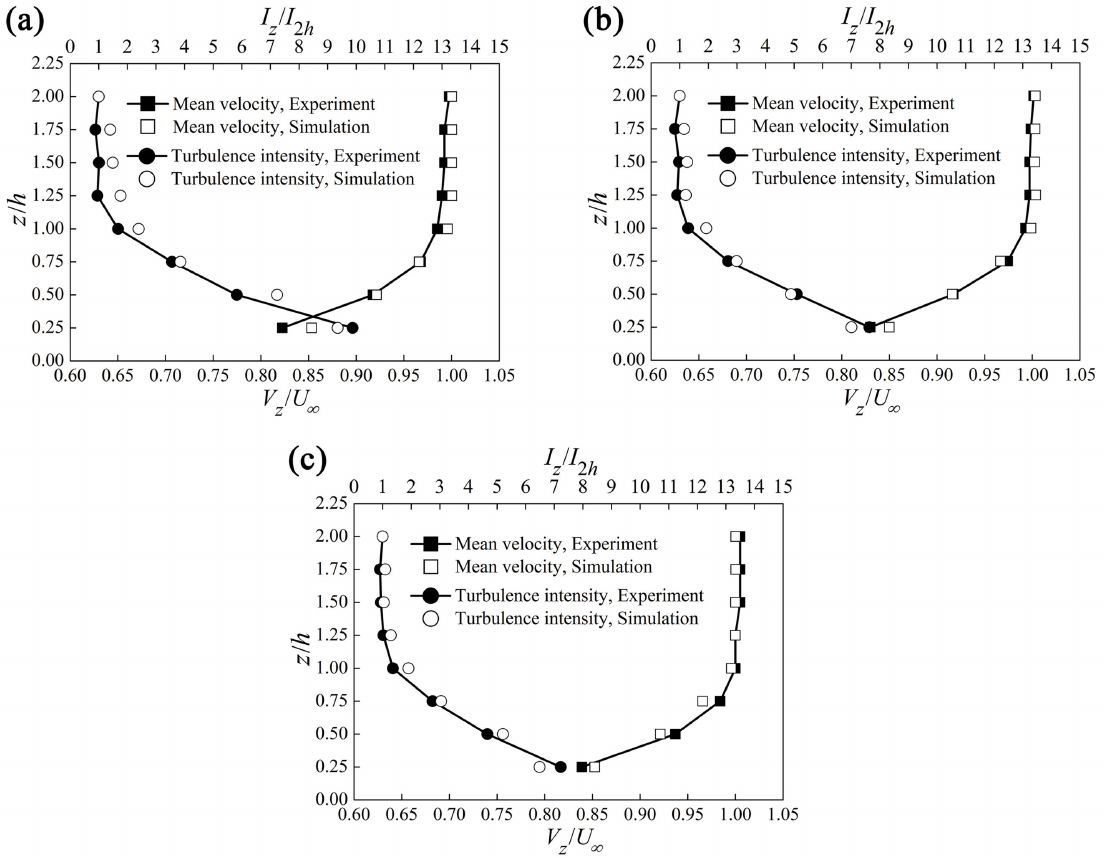
Figure 4. Profiles of mean velocity and turbulence intensity under di ff erent wind speeds U ∞ : ( a ) U ∞ = 4 m / s; ( b ) U ∞ = 7 m / s; ( c ) U ∞ = 10 m /